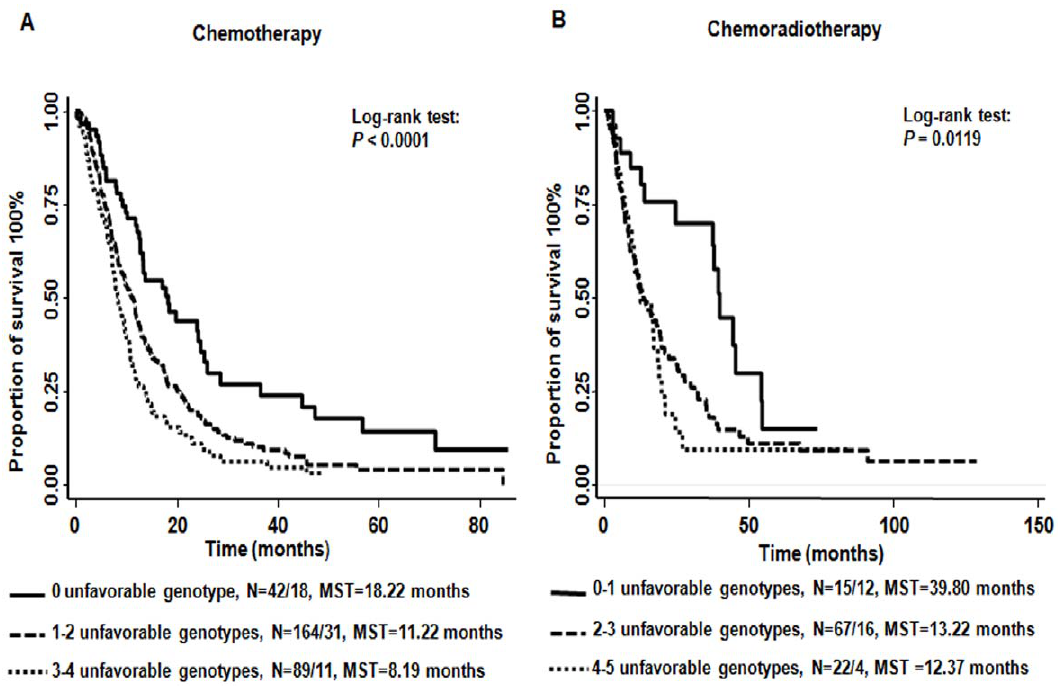
Figure 1. Kaplan-Meier estimates of the cumulative effect of unfavorable genotypes on NSCLC survival stratified by treatment. Solid line represents low-risk group, carrying 0 unfavorable genotypes in chemotherapy ( A ) and 0-1 unfavorable genotypes in chemoradiotherapy ( B ). Dashed line represents the medium-risk group, carrying 1-2 unfavorable genotypes in chemotherapy ( A ) and 2-3 unfavorable genotypes in chemoradiotherapy ( B ). Dotted line represents high risk group, carrying 3-4 unfavorable genotypes in chemotherapy ( A ) and 4–5 unfavorable genotypes in chemoradiotherapy ( B ). N: Number of Dead/Alive. MST: median survival time.